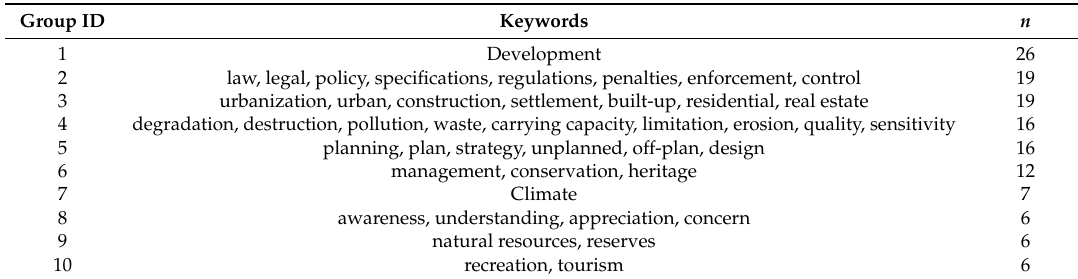
Table 1. Word groups used for the text analysis process of question